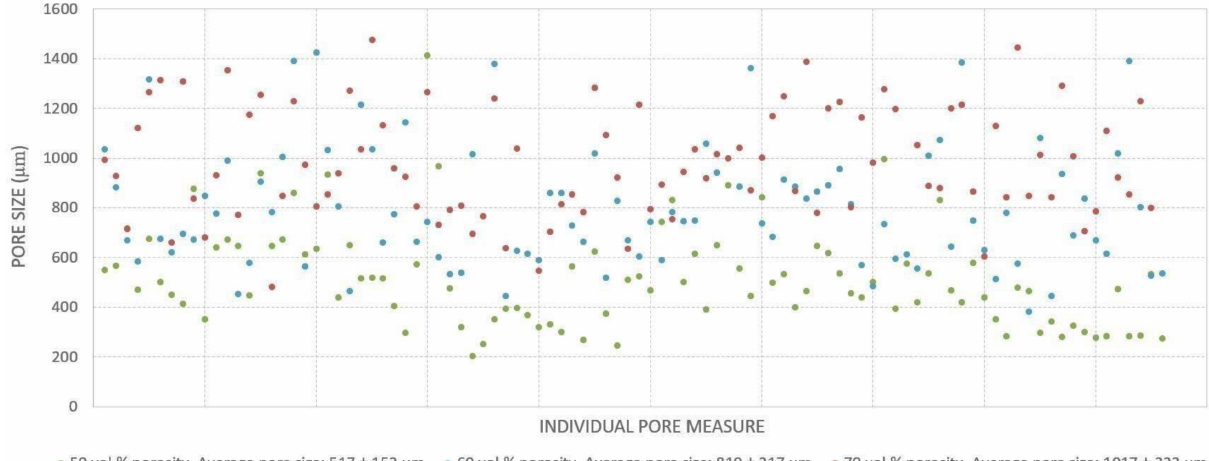
Figure 8. Dispersion and average pore size value in Al foams with 50, 60 and 70 vol.% of design